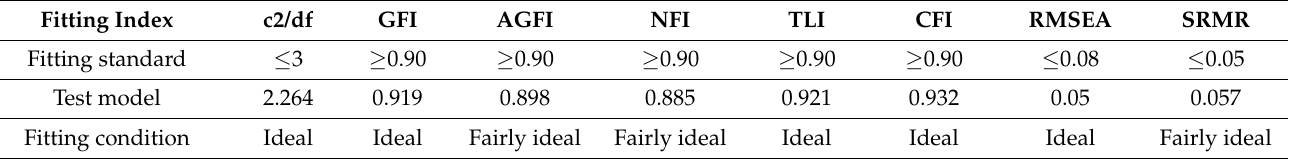
Table 6. Overall fitting index of the second-order factor model.